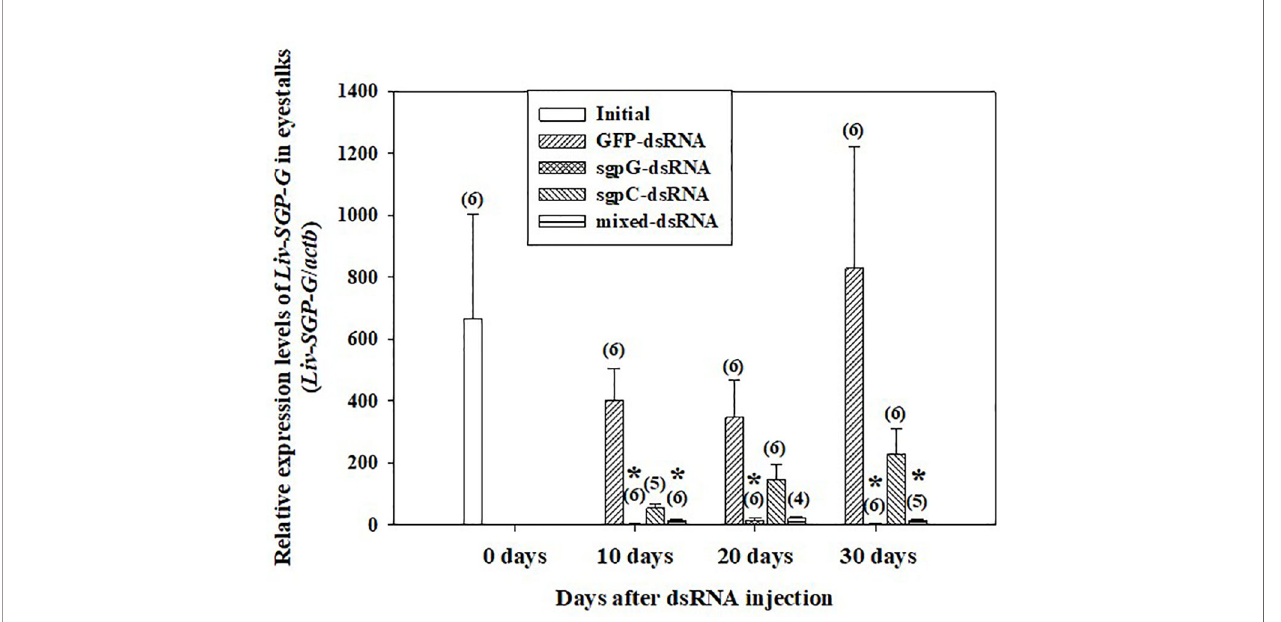
FIGURE 1 | Levels of Liv-SGP-G expression in eyestalks following a single injection of GFP-dsRNA, sgpG-dsRNA, sgpC-dsRNA, mixed-dsRNA, or no injection (initial). Results are expressed as the mean ± SEM. Asterisks indicate signi fi cant difference ( P < 0.05) from the initial group. Values in parentheses indicate numbers of shrimp analyzed in each group. Beta-actin is indicated as actb . The content of each treatment group is indicated in the legend box that appears above the bar